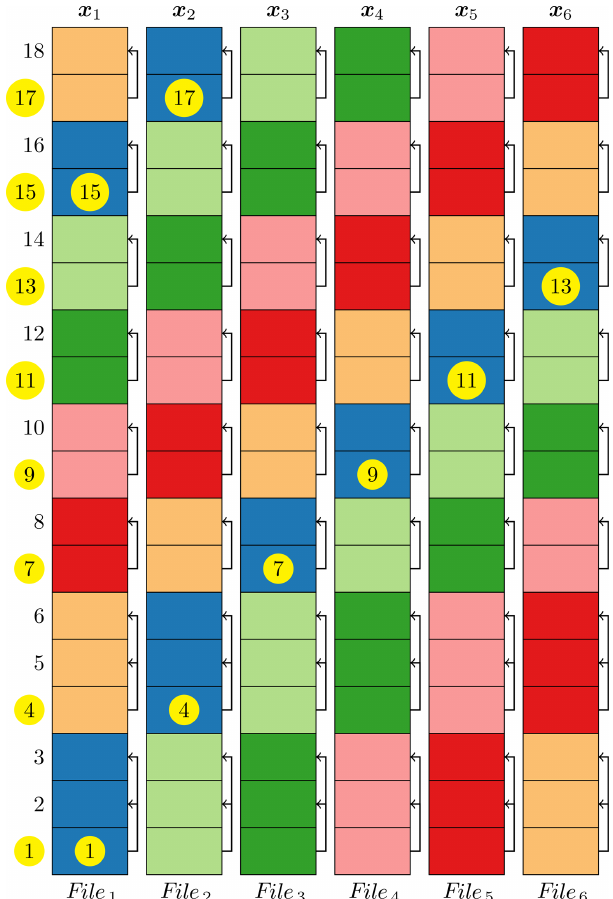
Figure 6. Schematic diagram illustrates the algorithm for reading N e ( N e = 6 for this example) forecast member files to a matrix X = (cid:2) x 1 , ··· , x 6 (cid:3) ; that is, each member file is read into its corre- sponding column of the matrix X . The numbers to the left of the first column are the ranks of the MPI tasks that are in charge of the corresponding row of the matrix X , and those with a yellow circle are the IO tasks. The cells with the same colour are read simulta- neously by the corresponding IO task, and then the IO tasks scatter the read-in data to the MPI tasks that they are in charge of. In the first stage, the IO tasks of 1 (cid:13) , 4 (cid:13) , 7 (cid:13) , 9 (cid:13) , 11 (cid:13) , 13 (cid:13) , 15 (cid:13) , and 17 (cid:13) read the cells with the purple colour and then, for example, the IO task of 1 (cid:13) scatters the read-in data to itself and the MPI tasks of 2 and 3. In subsequent stages, each IO task performs a right circular shift by one column and then reads and scatters. This pattern is repeated until all the files are